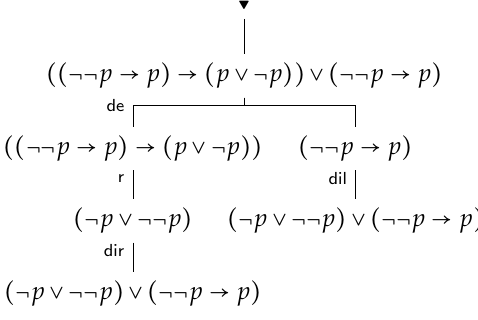
Figure 11. m-Inference of formula A